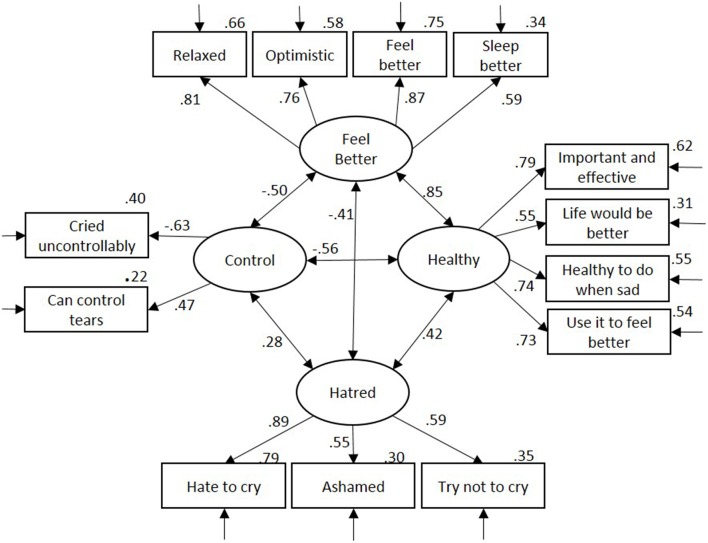
Confirmatory factor analysis for attitudes toward crying. Residual error terms are omitted for clarity of presentation. Variance in item explained by factor is displayed top right of each item.